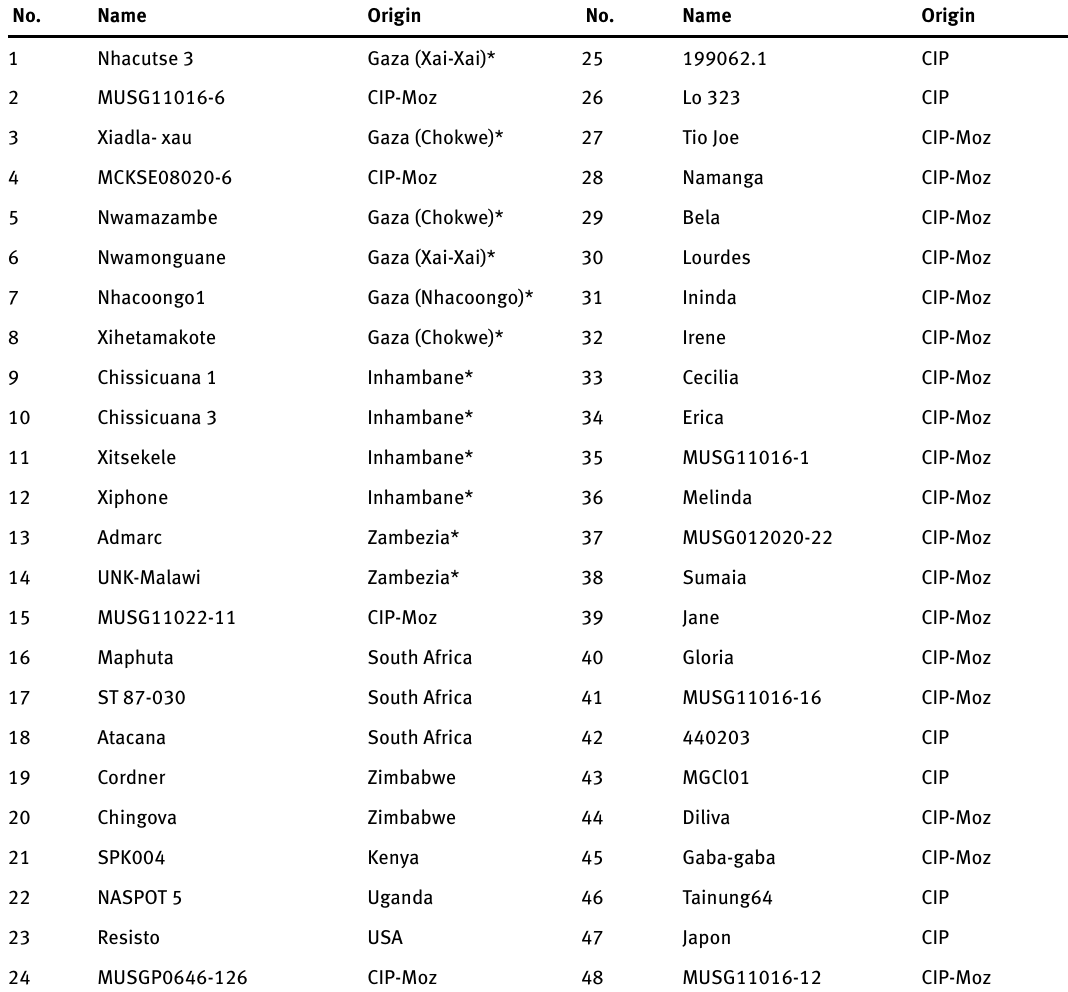
Table 1: List of germplasm evaluated for drought tolerance at Umbeluzi Research Station in 2015A and 2015B seasons